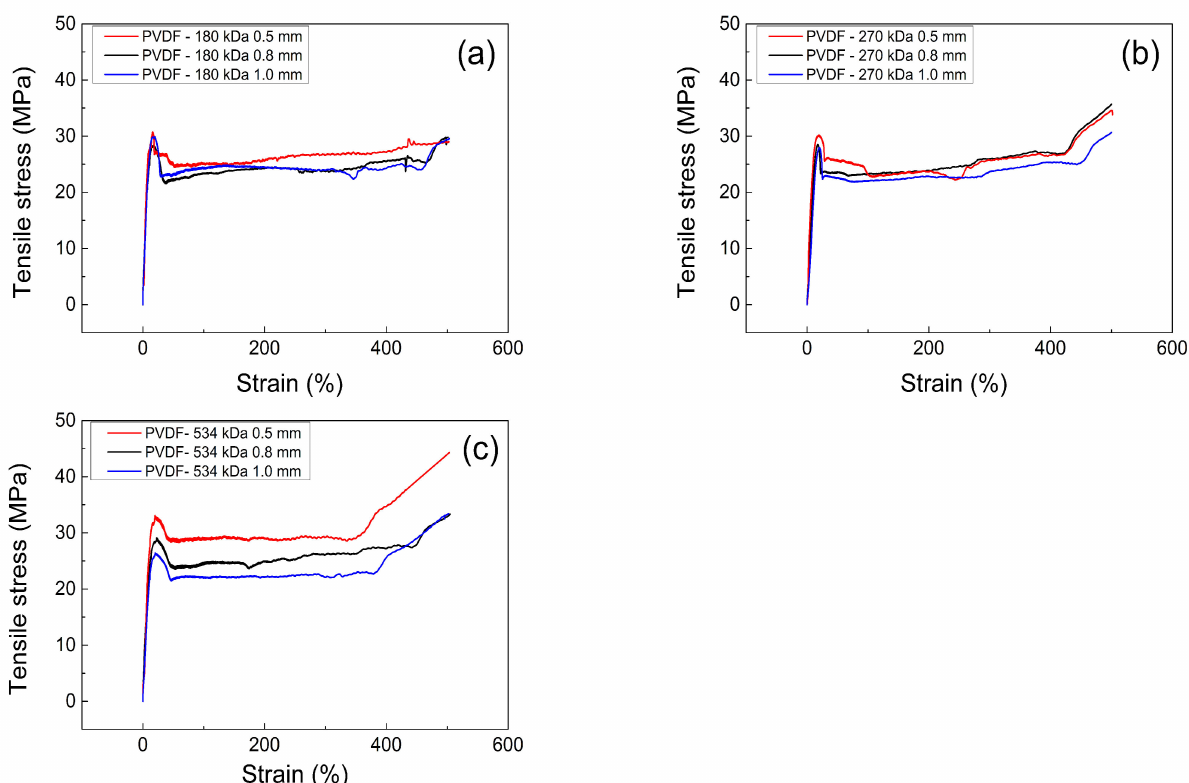
Figure 1. Dependence of the tensile stress on the strain for the PVDF samples with various Mw and the initial thickness of 0.5 mm (red), 0.8 mm (black) and 1.0 mm (blue) ( a ) 180 kDa ( b ) 270 kDa ( c ) 534